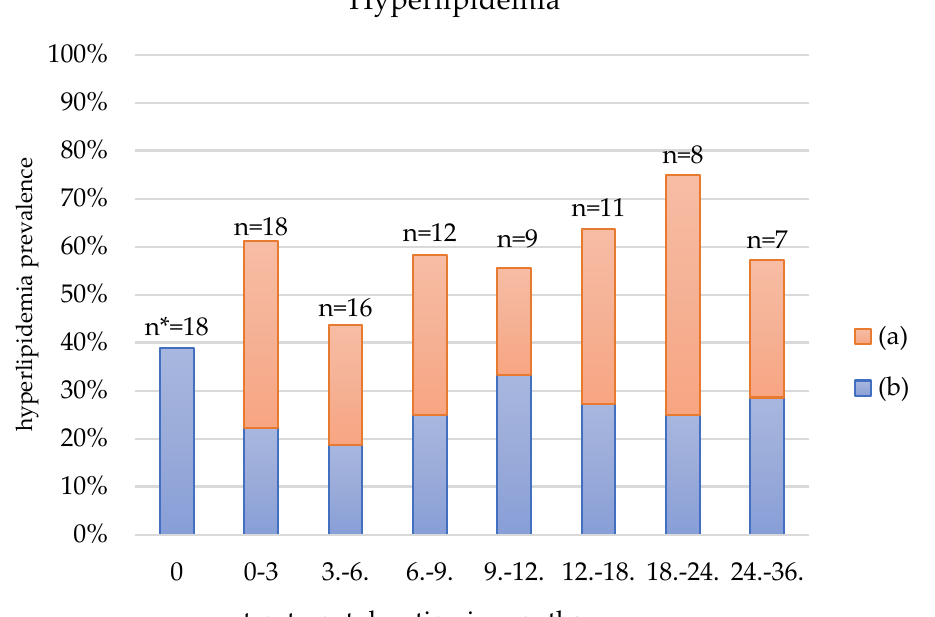
Figure 2. Elevated platelet count depending on the treatment duration in patients with: (a) platelet count within normal ranges prior to sirolimus treatment, (b) thrombocytosis prior to sirolimus treatment.